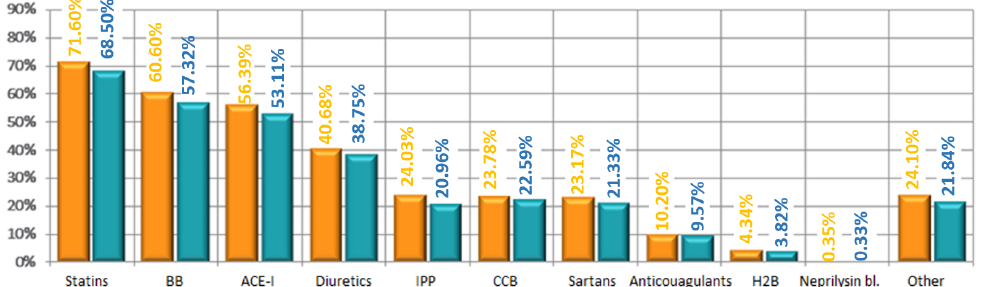
Figure 6. Pharmacotherapy in studied population (visit 1–visit 2) (BB—beta-blockers; ACE-I—angiotensinconverting enzyme inhibitor; IPP—inhibitor of proton pomp; CCB—calcium channel blockers; H2B—H2 receptor blockers; bl.—blockers).